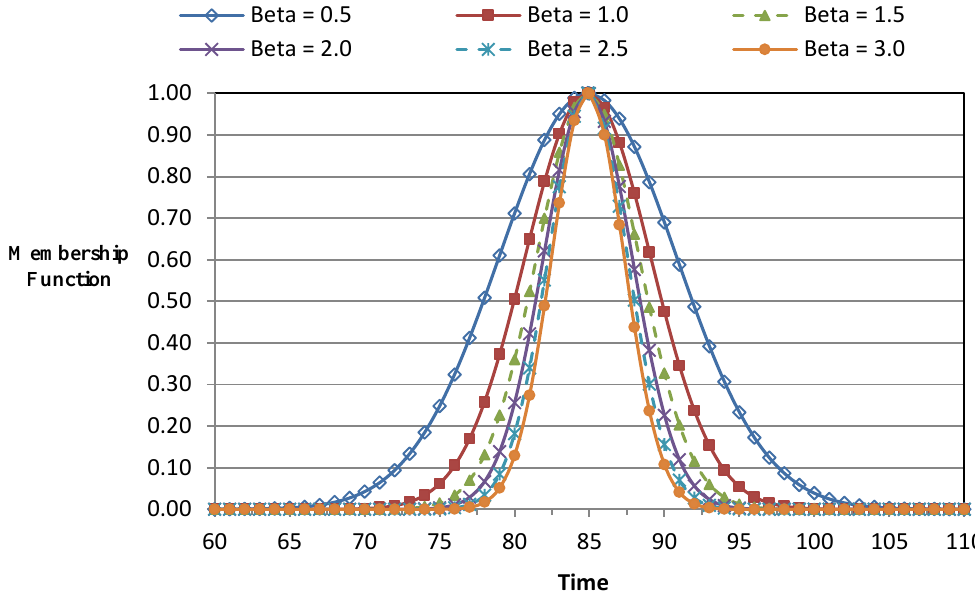
Figure 8. Effect of variation in β on travel